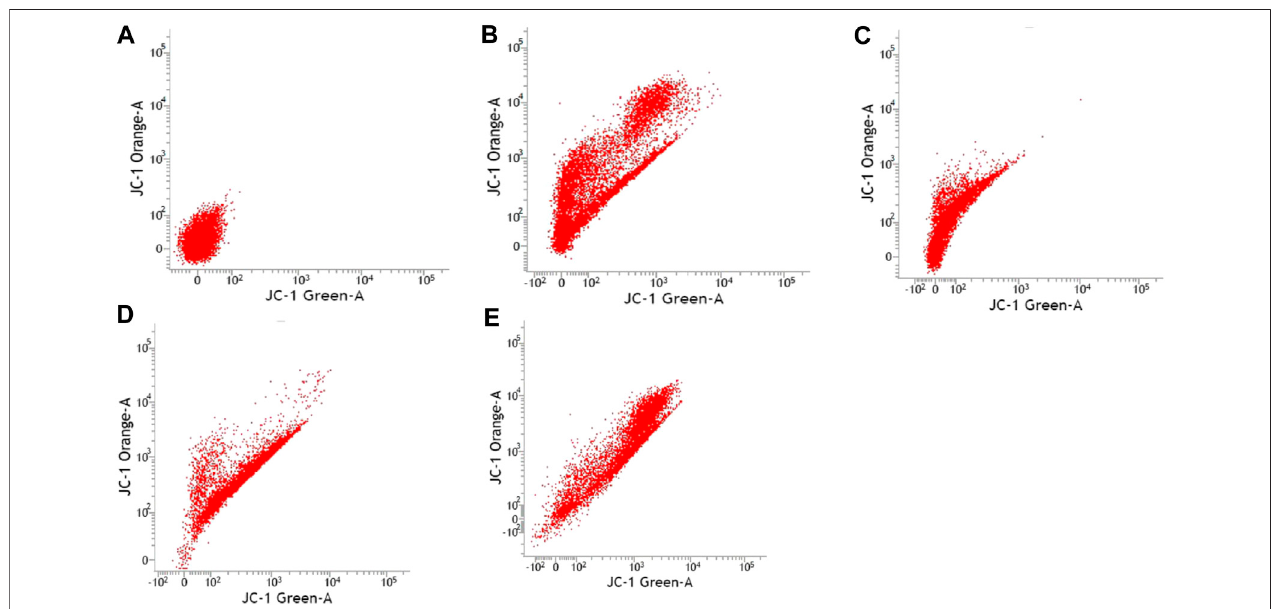
FIGURE 3 | Caco-2 cell lines with or without treatment with sialic acid using JC-1 Mito Probe by BD FACSAria ™ : (A) untreated cell; (B) control without CCP; (C) control with CCP; (D) treatment with standard sialic acid; (E) treatment with extraction of sialic acid.